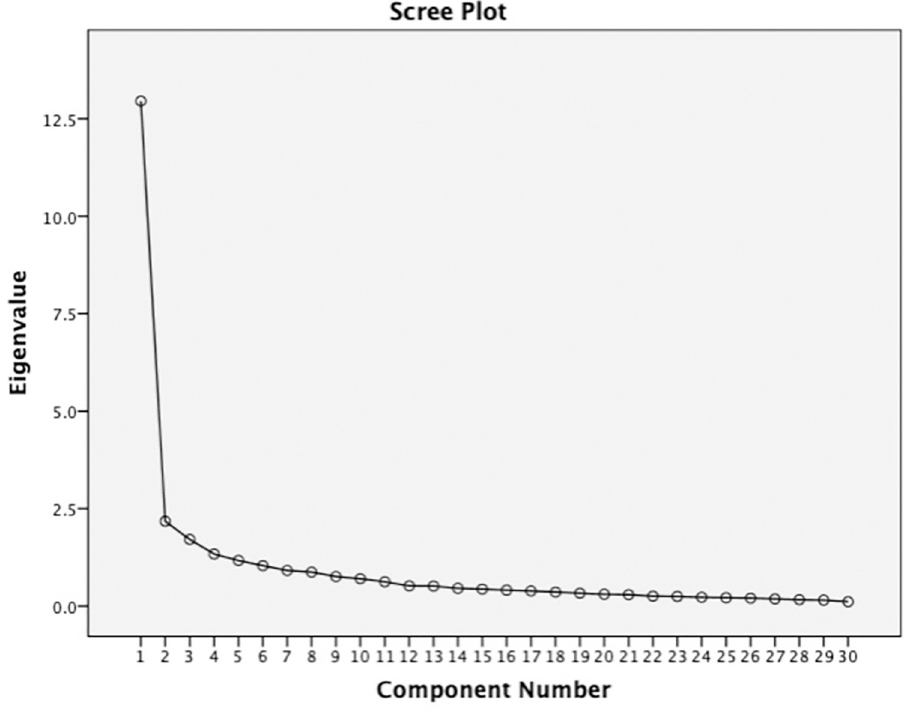
Fig 1. In this scree plot, the point at which the curve first begins to level off indicates that there is one dominant latent variable which is obviously dominant over the remaining latent variables.